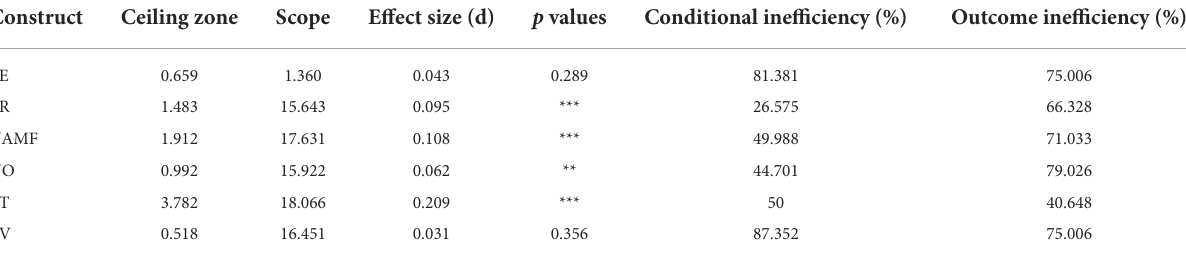
TABLE 6 Necessary condition analysis result (method: CE-FDH).